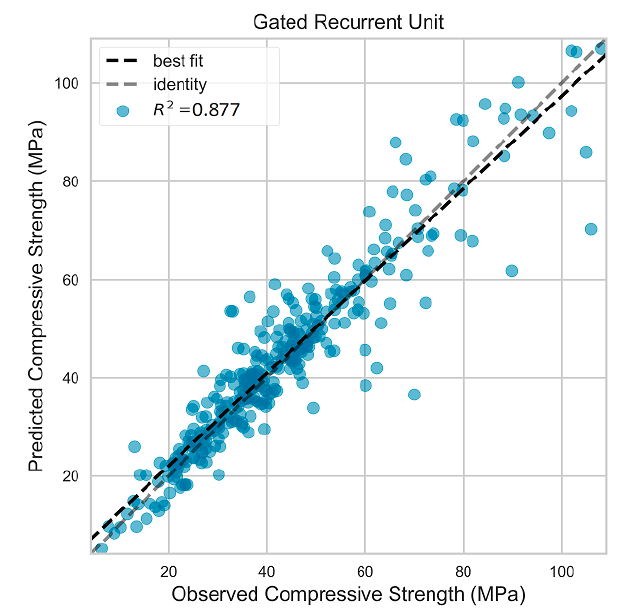
Figure 8. Actual vs. predicted values for testing set in deep learning model.